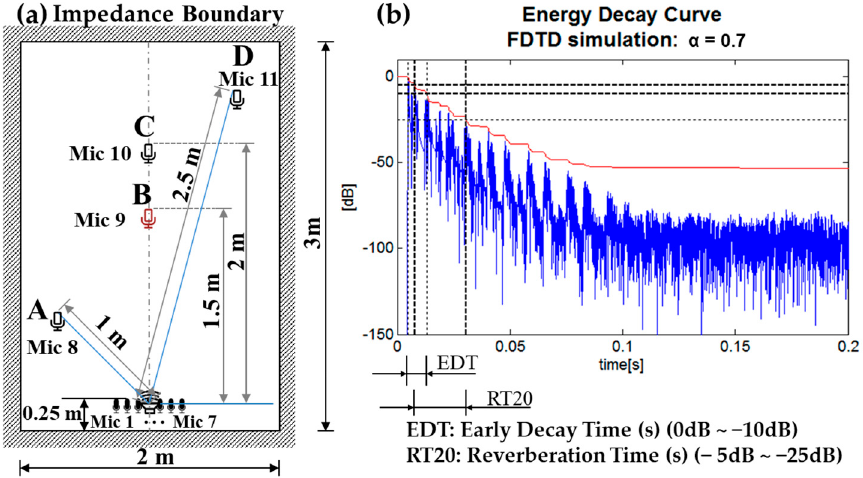
Figure 10. Configuration of ( a ) acoustic parameter tests to verify the active localization method according to the change in absorption coe ffi cient α . ( b ) Energy decay curve of the ninth microphone.